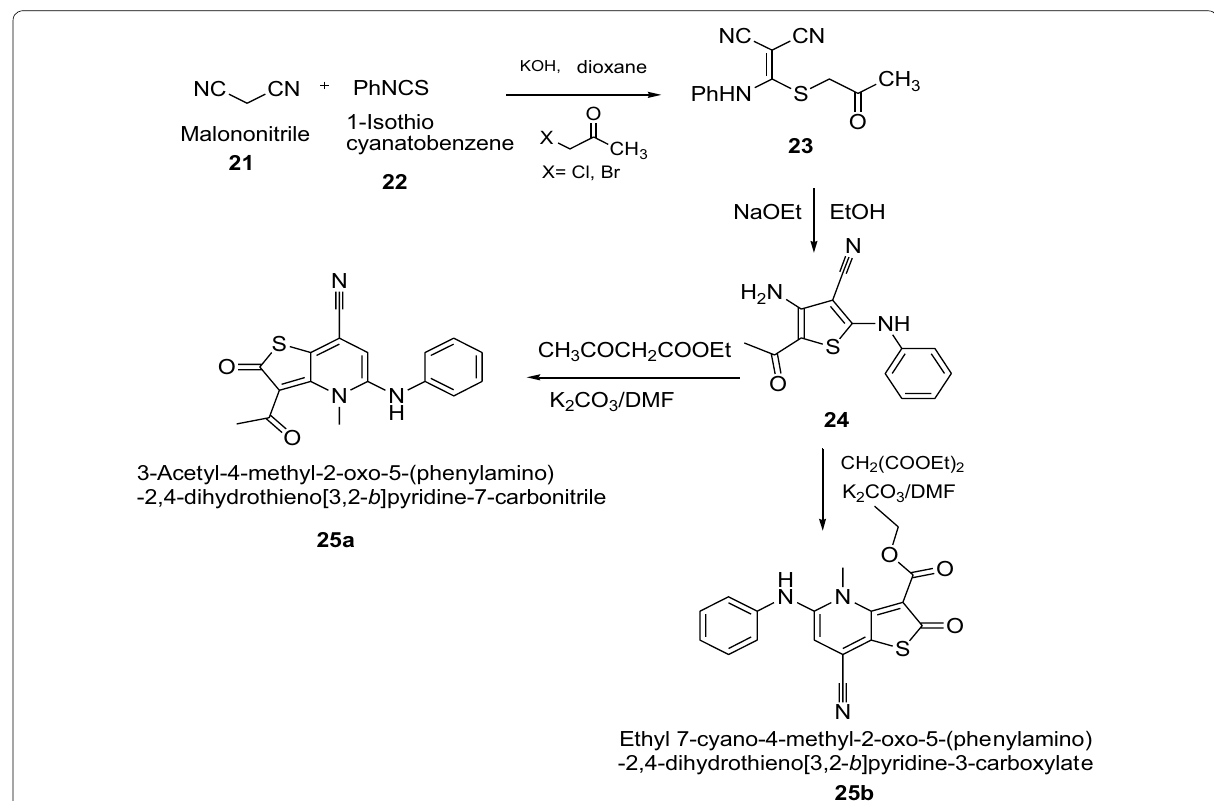
Table 6 The in vitro antibacterial activity of the synthesized thienopyridines derivatives Compound Gram-positive